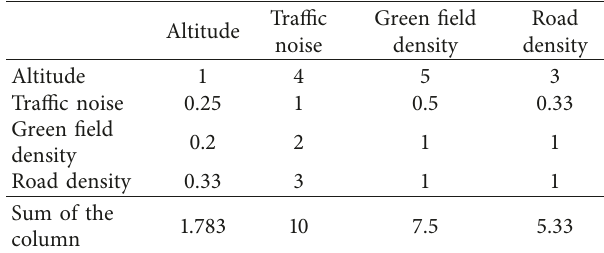
Figure 6: Traffic noise map. Table 2: Relative importance of weightings.